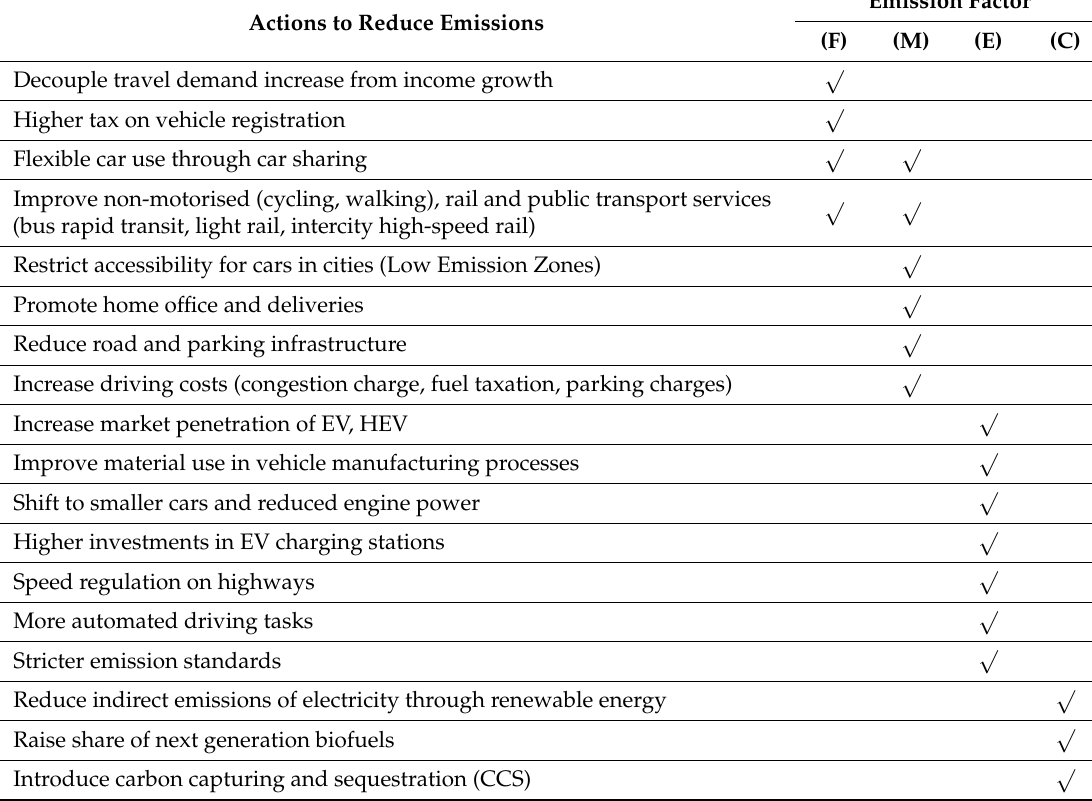
Table 2. Actions to reduce car emissions and the targeted emission factor. Source: [10] and own